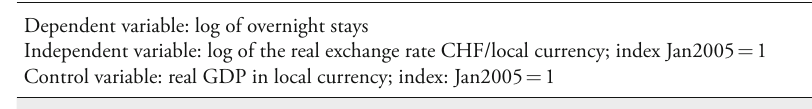
Table 4: Tourism Intensity of